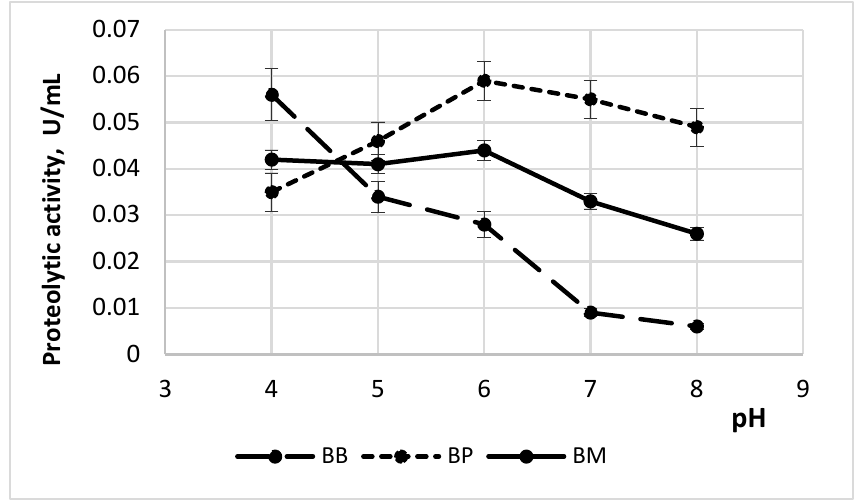
Figure 1. Protease activity of plant enzymes at different pH (BB, bran treated with bromelain; BP, bran treated with papain; BM, bran treated with combination of bromelain and papain).